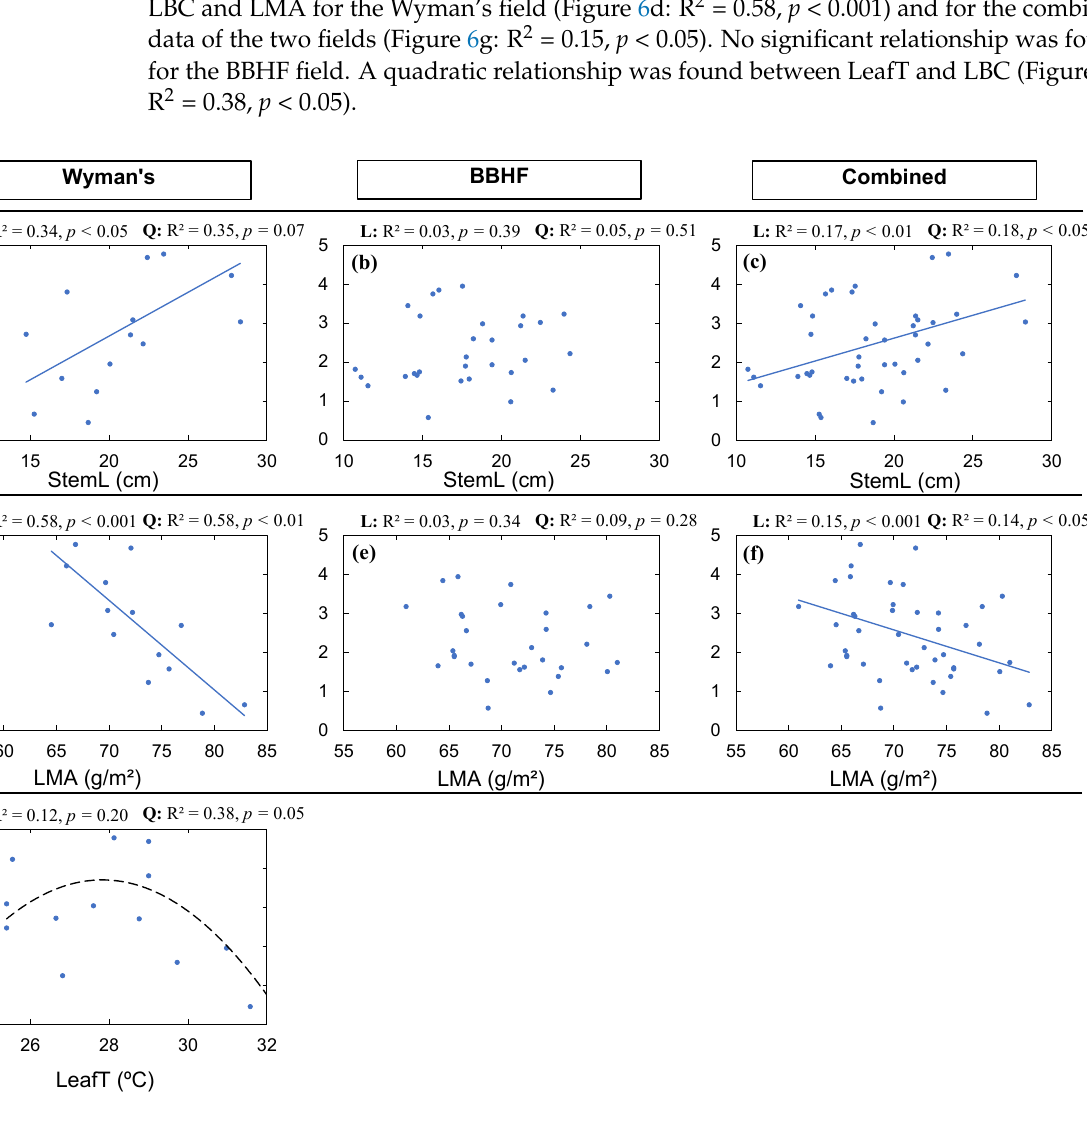
Figure 6. Average length of berry cluster (LBC) in wild blueberry fields in relation to average stem length (StemL) ( a – c ); average leaf mass per area (LMA) ( d – f ); and average leaf temperature (LeafT) ( g ). The solid blue lines indicate significant ( p < 0.05) linear relationships, and black lines indicate significant ( p < 0.05) quadratic relationships. Dashed lines indicate marginally significant ( p < 0.10) relationships. Here, among all the structural and functional traits, only significant or marginally significant relationships to LBC were plotted. The strongest relationship was selected from the high level of significance ( p -value) and higher coefficient of determination (R²).